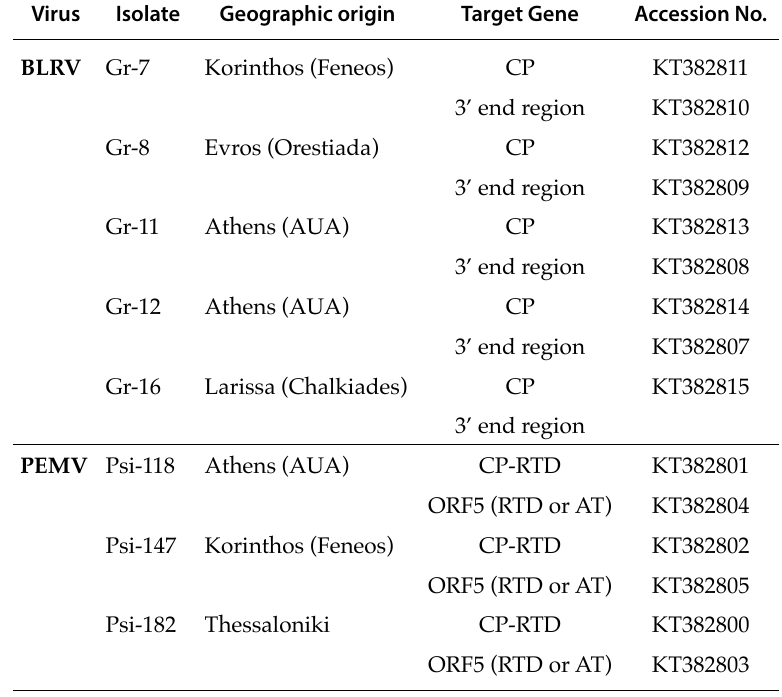
Table 1. Listing and geographical origin of lentil Bean leafroll virus (BLRV) and Pea enation mosaic virus (PEMV) isolates characterized in this study, and sequences deposited at